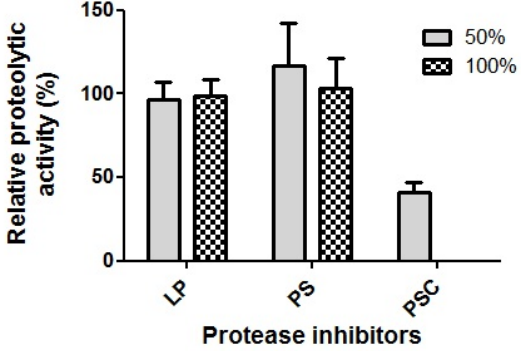
Figure 6. Effect of protease inhibitors on the proteolytic activity of SK1-1. The crude protease was treated with three individual protease inhibitors (LP, leupeptin; PS, pepstatin; PSC, Pefabloc ® SC) prior to the enzyme-substrate reaction. The terms ‘50%’ and ‘100%’ indicate the full and half amount of the manufacturer’s recommended dose, respectively. This experiment was performed in triplicate, and the results are expressed as mean values with standard errors.